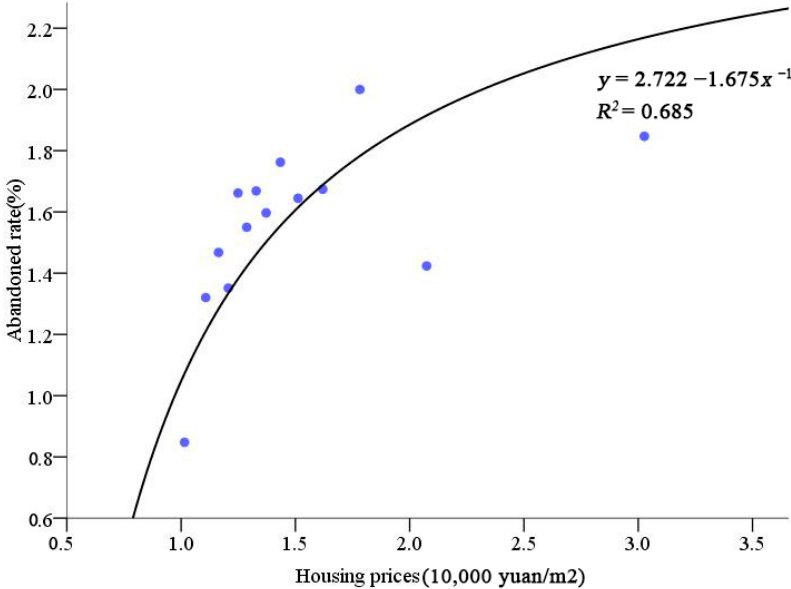
Figure 7. Fitting curve of housing prices and abandonment rate.